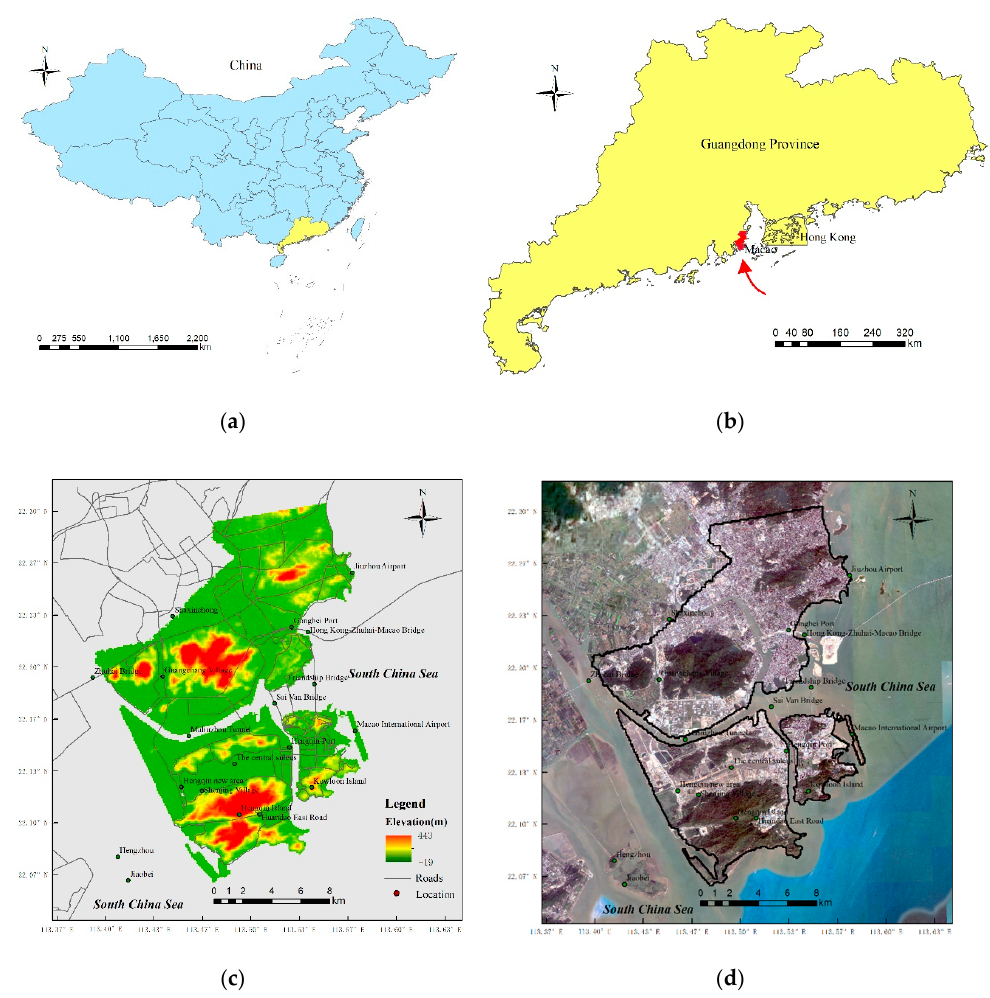
Figure 2. Location of the study area. ( a ) Administrative map of China; ( b ) map of Guangdong Province; ( c ) topographic map of the study area; ( d ) remote sensing map of the study area.